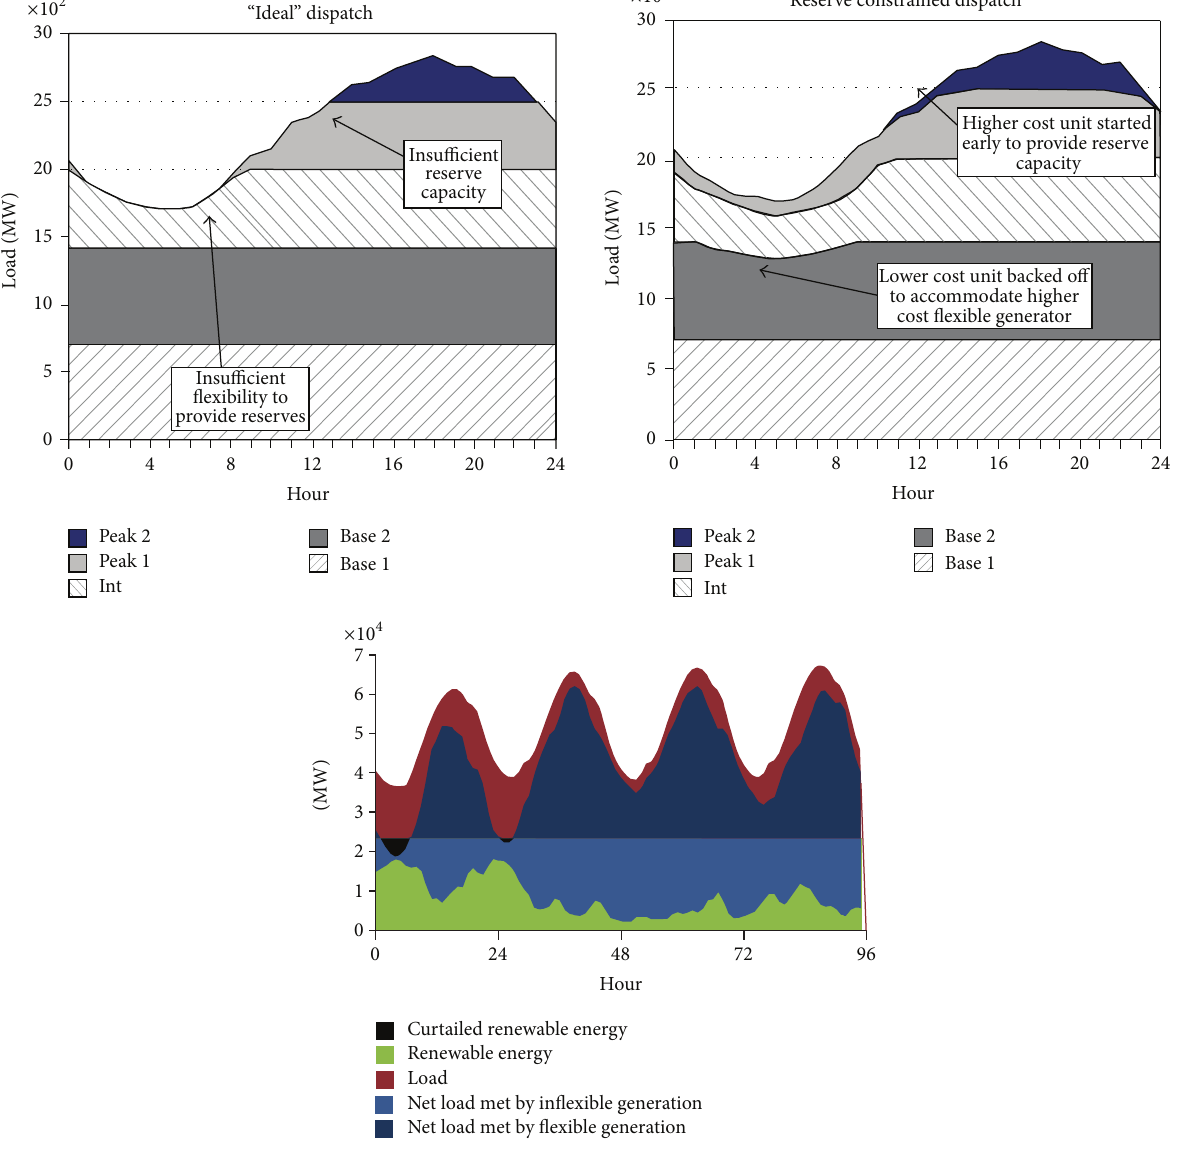
Figure 6: Example of UCOD based